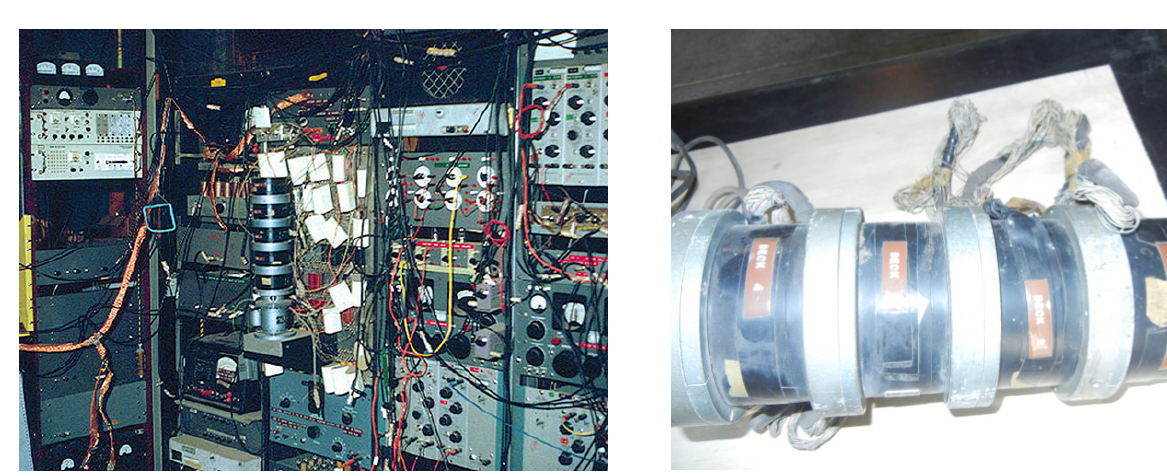
Figure 11. Original reception and integration system at the Jica- marca Radio Observatory. Reception was done with modified Ham- marlund 600 receivers. Range gating and integration depended on a mercury jet commutator (picture taken by Granger Morgan).